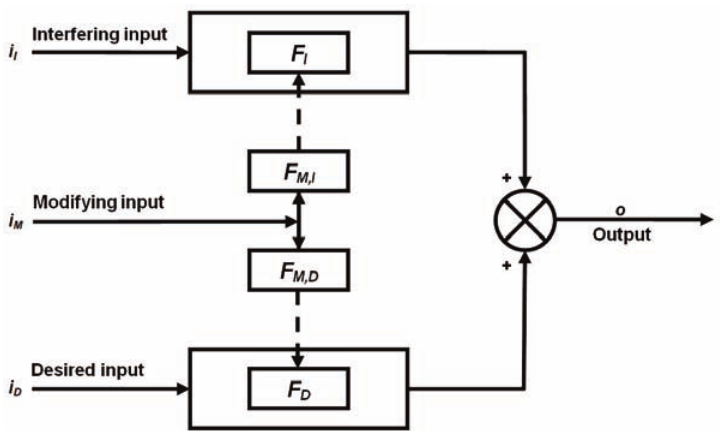
Figure 3. Scheme of a generalized configuration that highlights the significant input-output relationships present in all measuring apparatus (after Doebelin [1990]); see text for details.